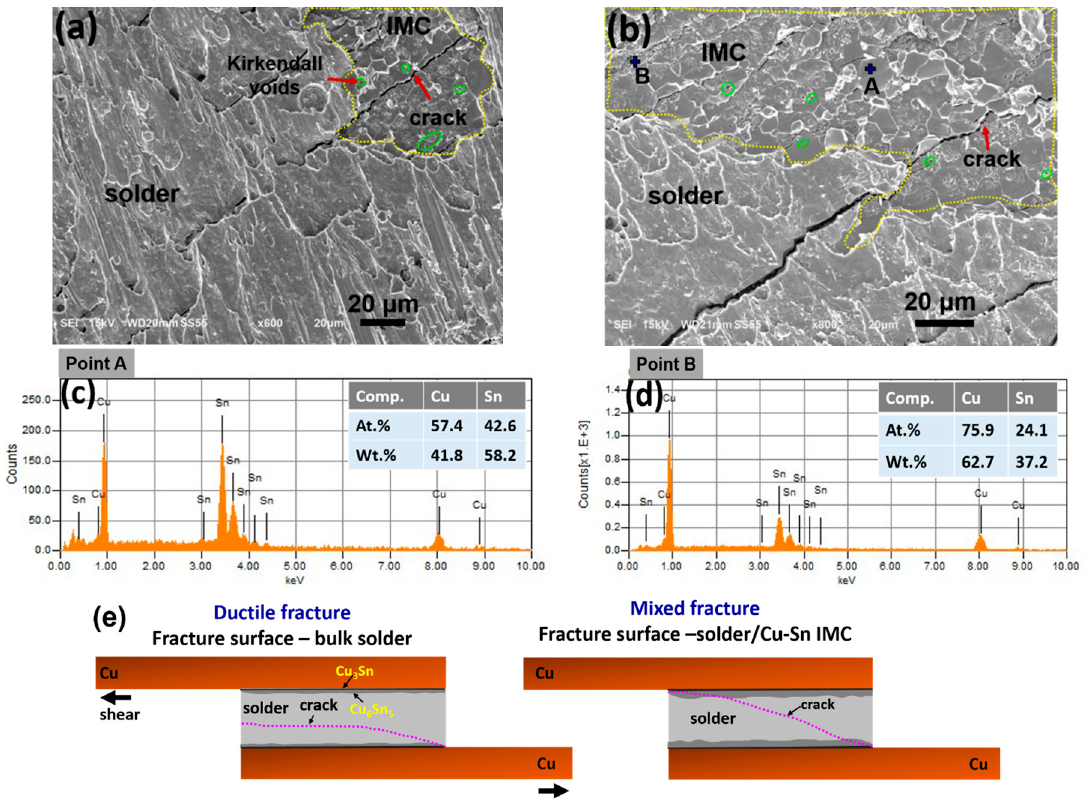
Figure 10. Solder / IMC fracture and crack propagation in 256 h isothermally aged ( a ) SAC 305-ZrO 2 A / Cu joint, ( b )SAC305-ZrO 2 B / Cujoint, ( c , d )EDSanalysiscorrespondingtopointsAandBin(b), ( e )schematic illustration of the fracture